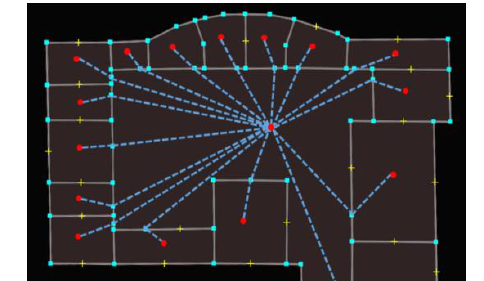
Figure 1. NRG graph